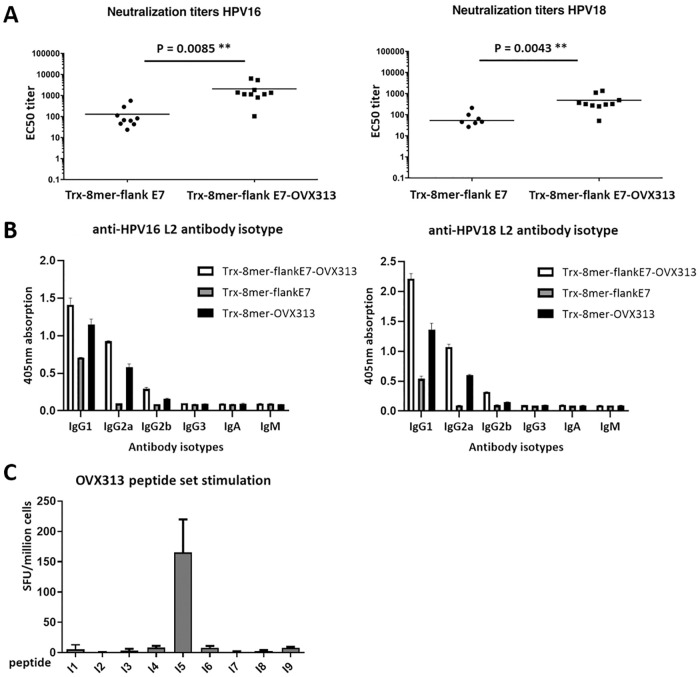
OVX313 domain enhanced generation of L2-specific antibodies.(A) Sera collected from vaccinated mice (10 animals per group) one month after the last immunization with Trx-8mer-flank E7 or Trx-8mer-flank E7-OVX313, were analyzed against HPV16 (left) and HPV18 (right) pseudovirions using the L1-PBNA. Each symbol represents the neutralization titer (EC50) of an individual mouse; geometric means of the titers for each group are indicated by horizontal lines. EC50 values of three Trx-8mer-flank E7 immunized mice are lower than 50 (the EC50 value set as threshold for neutralization positivity); the corresponding data are thus not shown in the graph. P-value ≤ 0.05 was considered as significant. *, P-value < 0.05; **, P-value < 0.01. (B) Analysis of isotype distribution of L2-specific antibodies measured by antibody isotype ELISA; the values are the mean ±SD of data obtained from duplicate assays performed on the pooled sera from each immunization group. (C) A T-helper response is induced by the ‘OVX313-I5’ peptide. Mice were immunized twice at 5 days intervals with the Trx-8mer-flank E7-OVX313 antigen. The splenocytes were stimulated with the OVX313 peptide panel (OVX313-I1 to OVX313-I9; see ‘Materials and methods‘ for details). Data, representing the numbers of IFN-γ spots per 106 splenocytes, are the mean ±SD of three mice for each peptide stimulation.